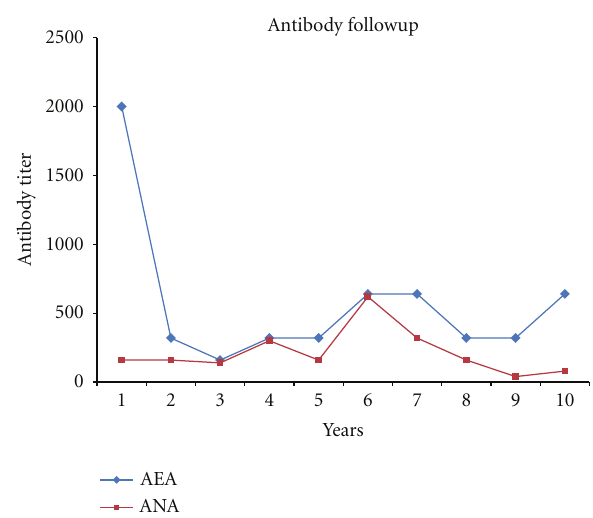
Figure 5: Antibody followup in three patients with pemphigus erythematosus (average of antibody